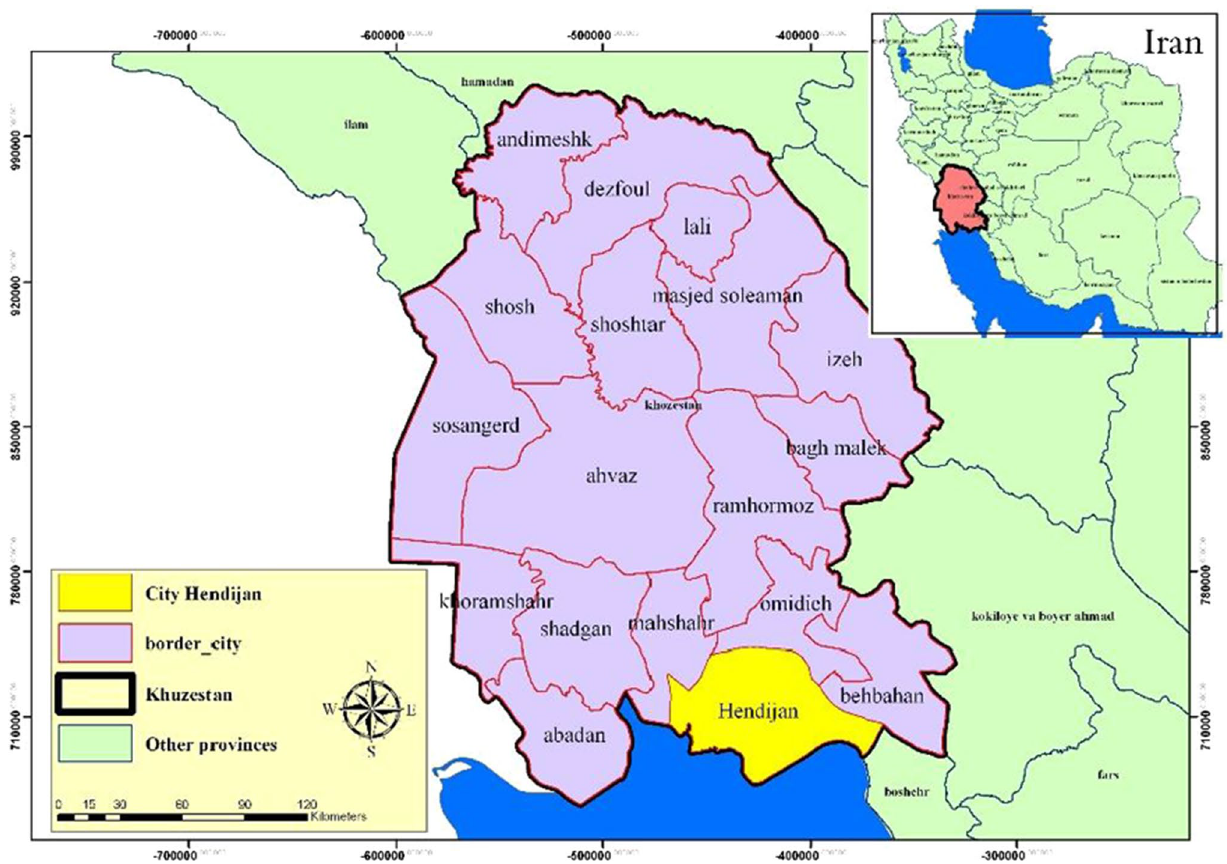
Fig. 1 Khuzestan south west of Iran and Hendijan